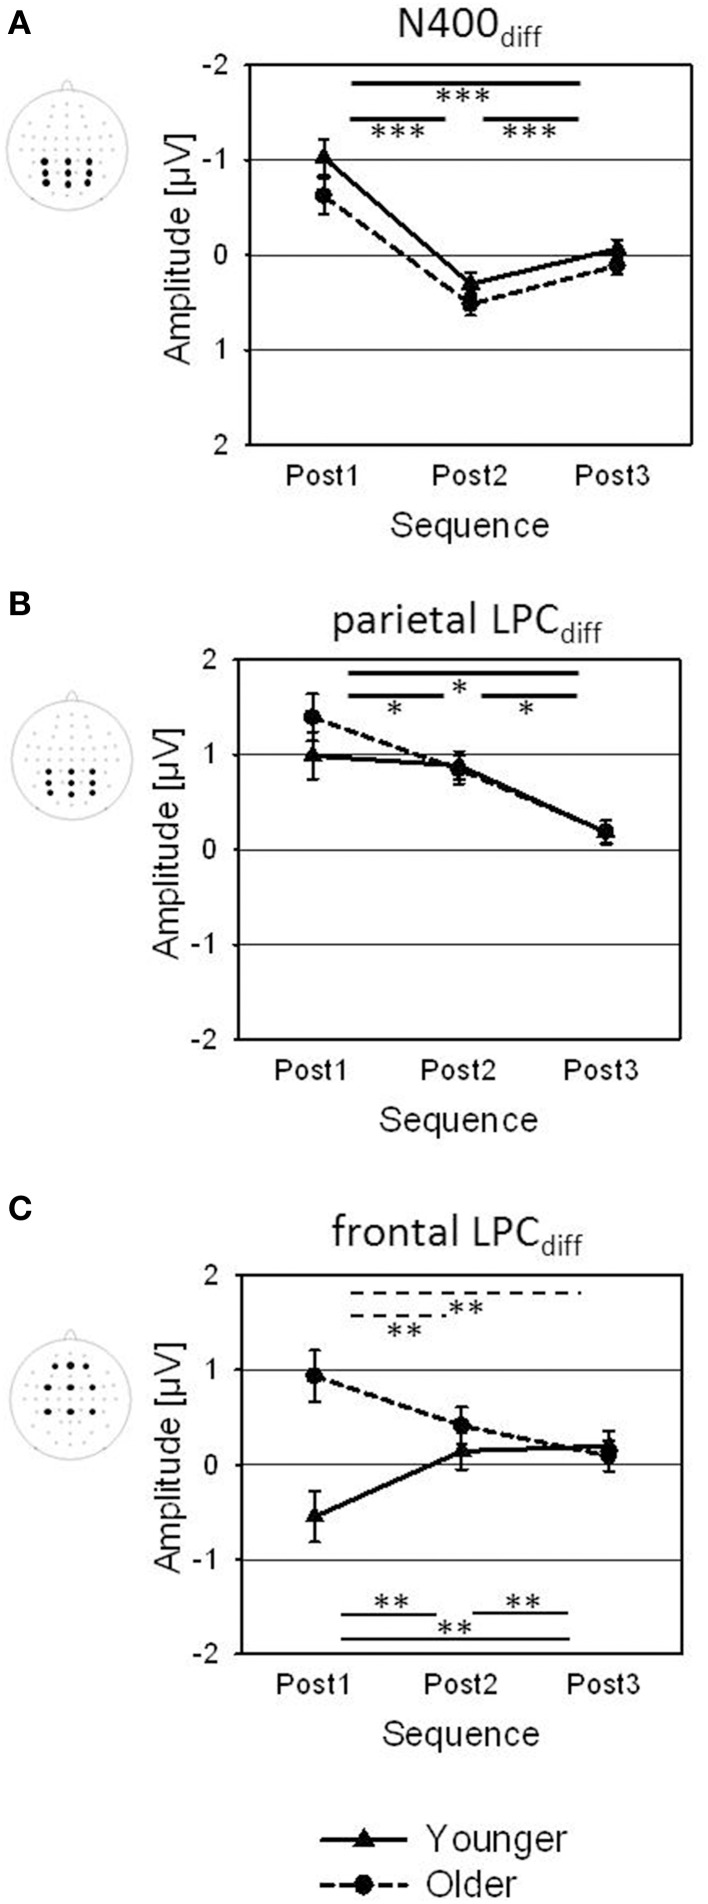
Amplitudes of the change-related ERPs [(A) N400diff, (B) parietal and (C) frontal LPCdiff; averaged across the displayed electrode arrays] for Post1, Post2, and Post3 sequences, shown for younger and older participants. Error bars are standard errors across participants (N = 22). Significance bars and asterisks indicate significant differences between sequences in the younger group (solid), in the older group (dotted), or averaged across both groups (bold; *p < 0.05; **p < 0.01; ***p < 0.001).